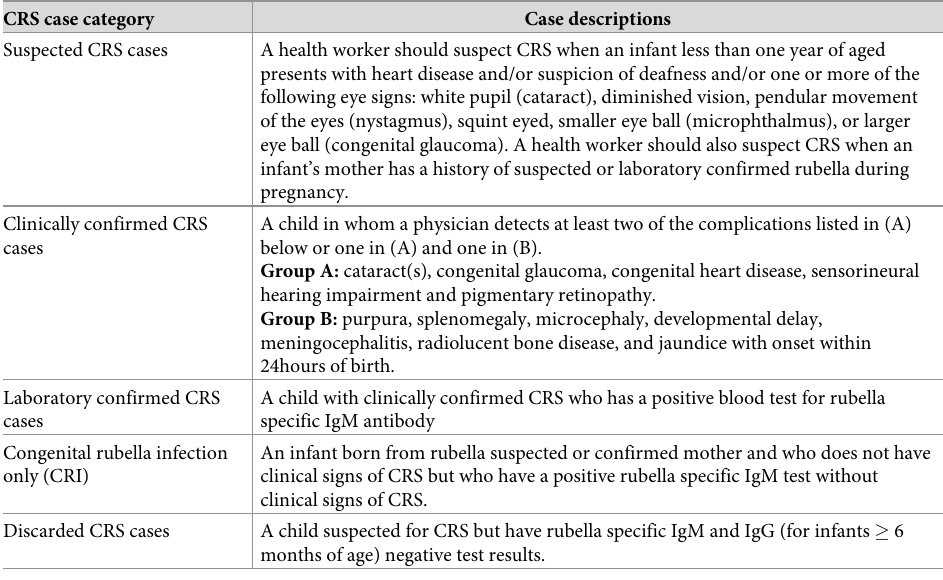
Table 1. CRS cases classified to the WHO case